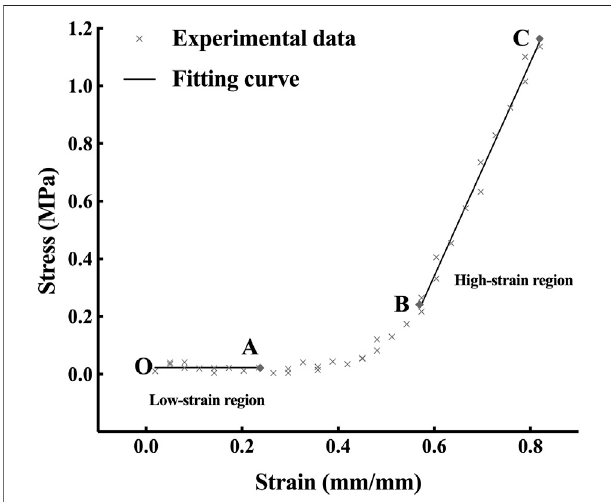
FIGURE 4 | The stress-strain curve of a corneal strip.